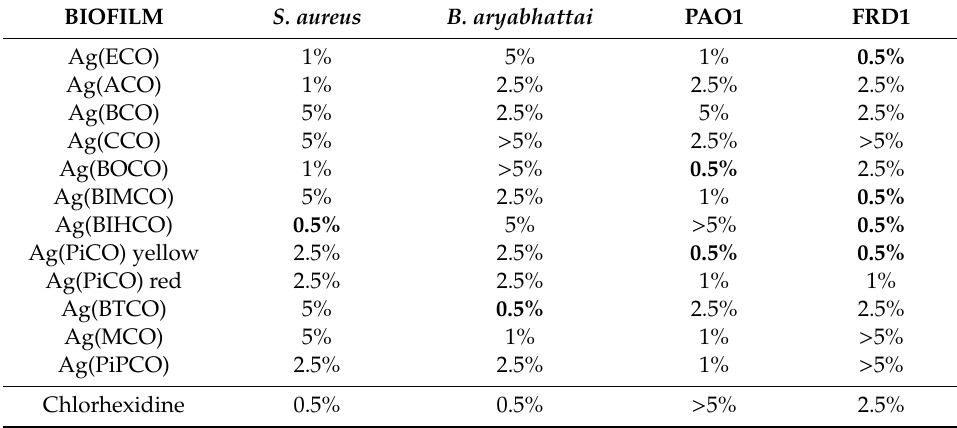
Table 4. The concentrations of the tested silver(I) cyanoximates embedded into polymeric composite that inhibited biofilm growth. The lowest inhibiting concentrations (0.5%) are shown in bold. Chlorhexidine was used as a reference